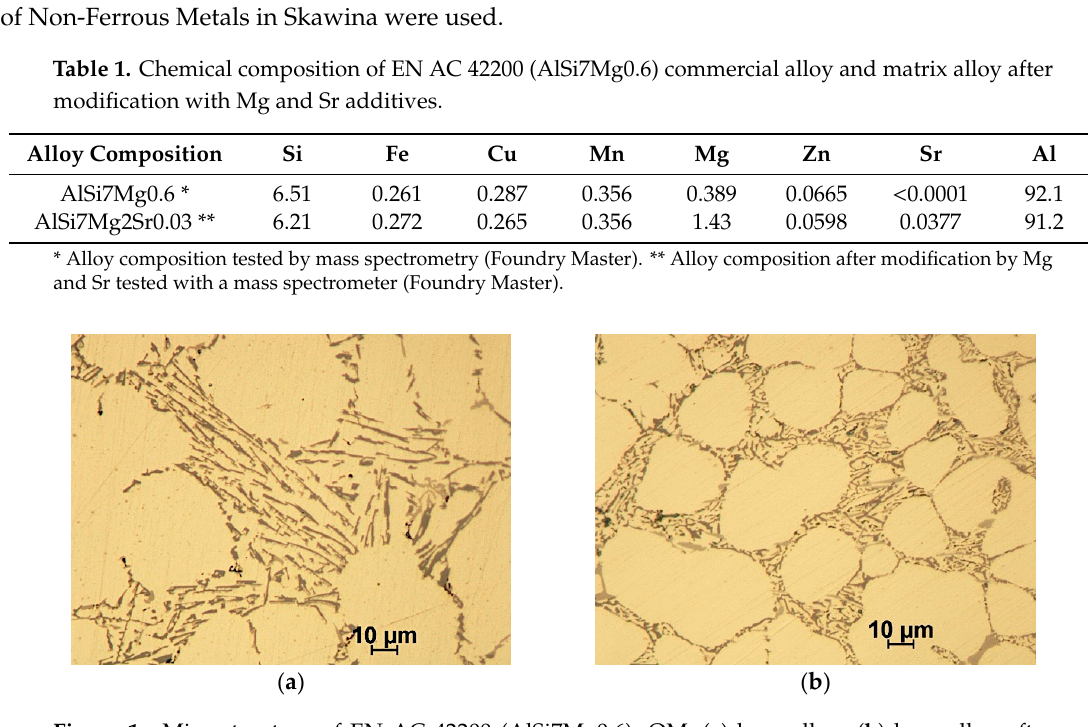
Figure 1. Microstructure of EN AC 42200 (AlSi7Mg0.6), OM : ( a ) base alloy; ( b ) base alloy after modification by Mg and Sr.